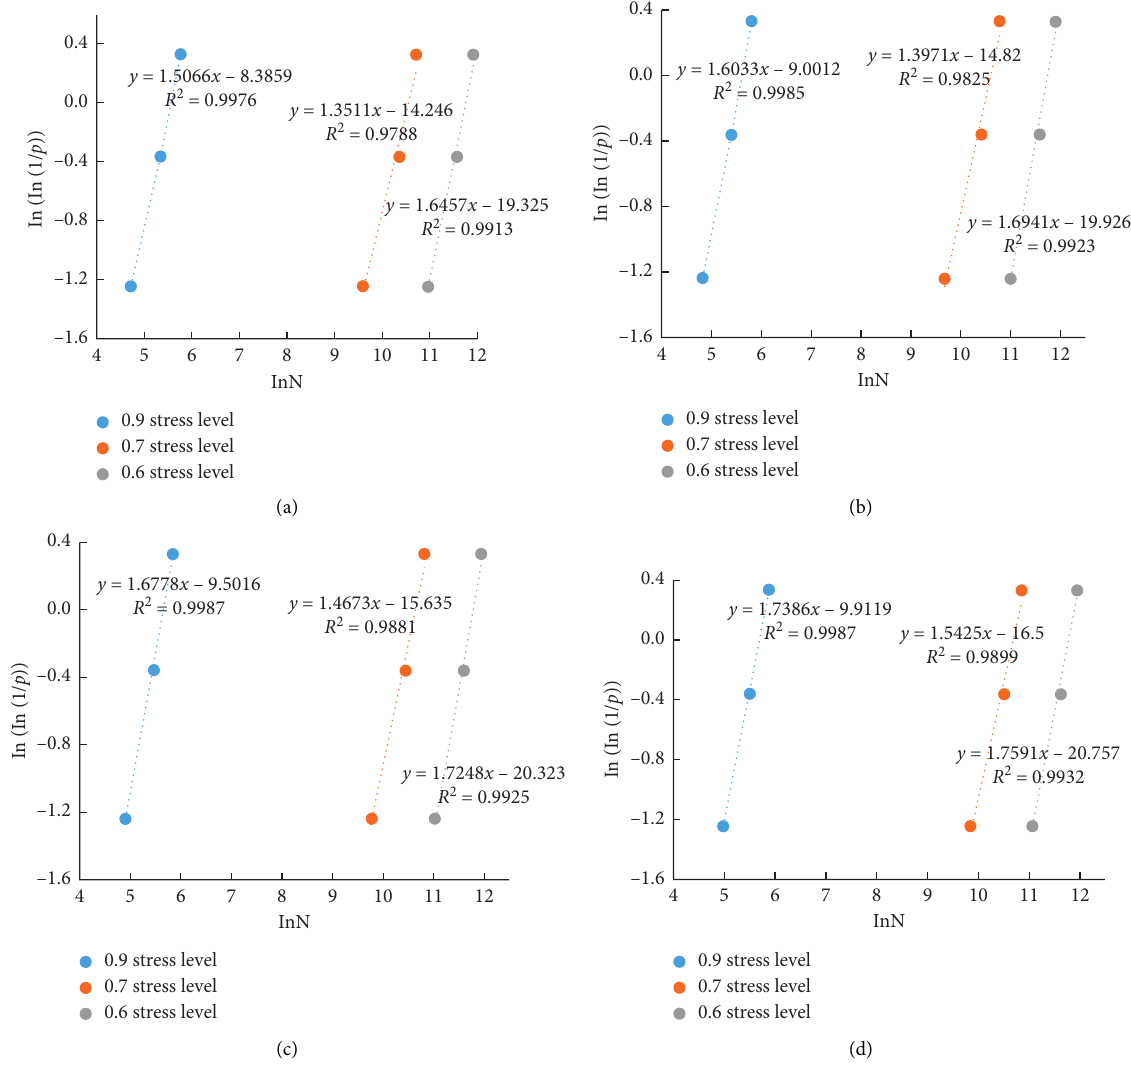
Figure 7: RC linear regression. (a) RC (0d). (b) RC (30d). (c) RC (60d). (d) RC